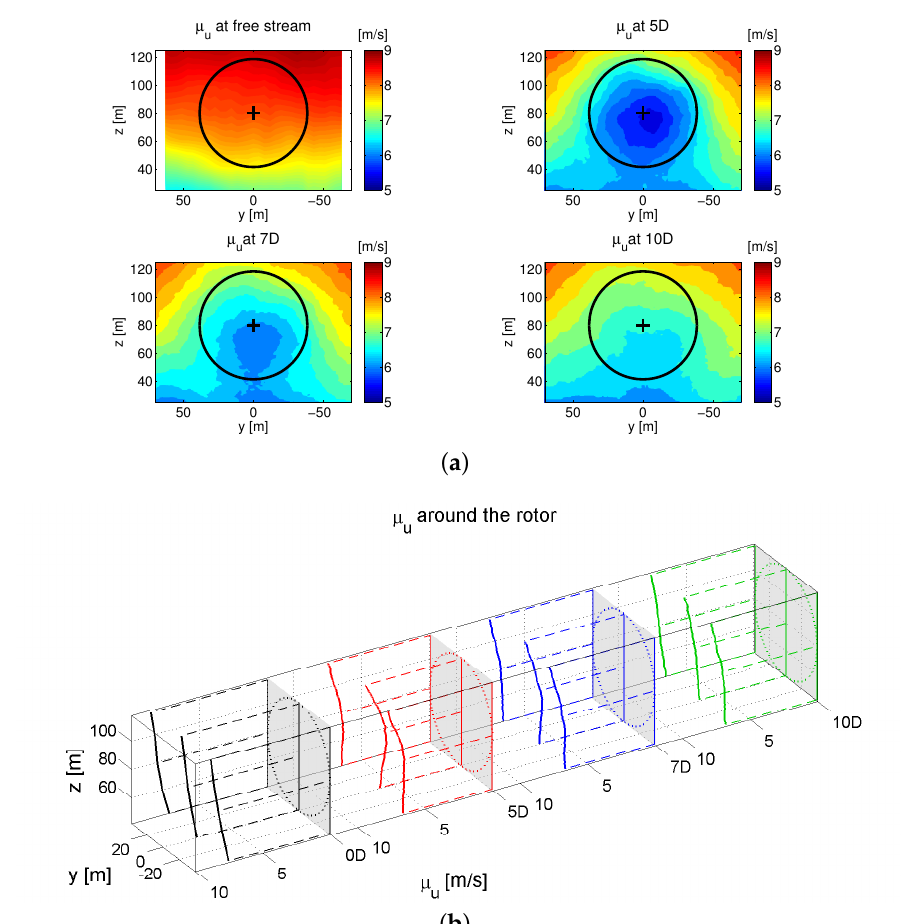
Figure 7. Spatial variation µ u in the waked field versus the free-stream field: ( a ) variation of µ u in vertical planes; and ( b ) profile of µ u .